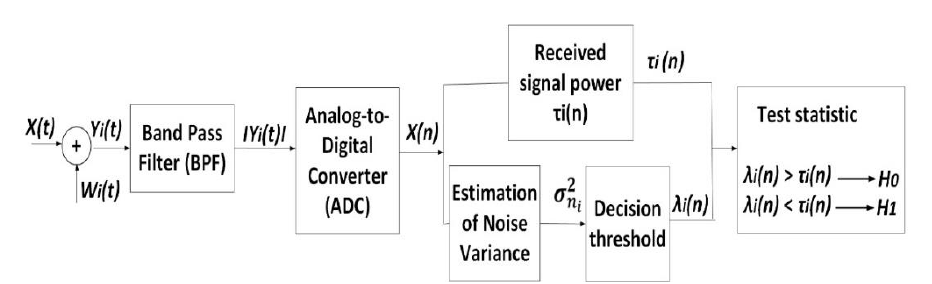
Figure 3. Block diagram of the energy detection process.